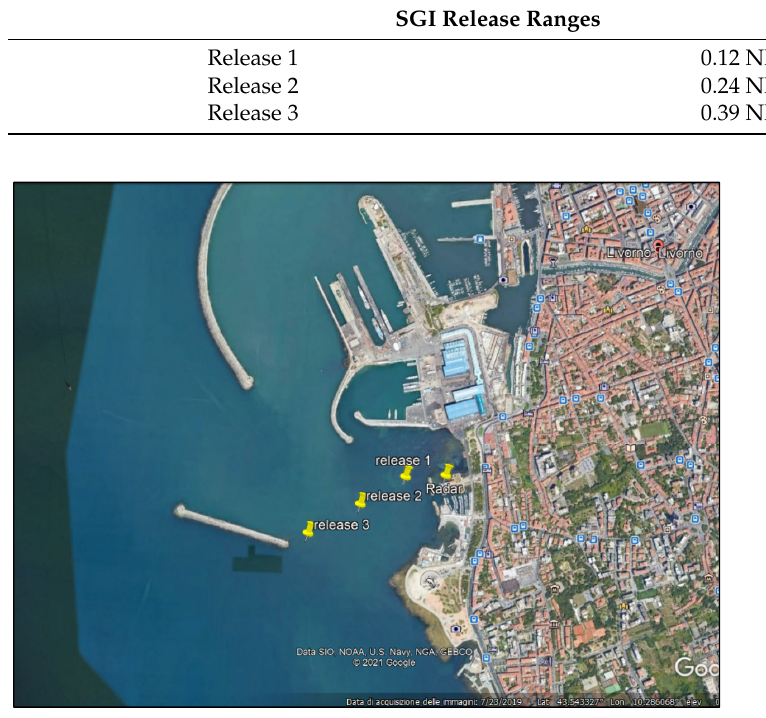
Figure 6. Map with the locations of the releases of the SGI modules (Google, images © 2019 CNES). Table 3. Release ranges of the SGI modules.